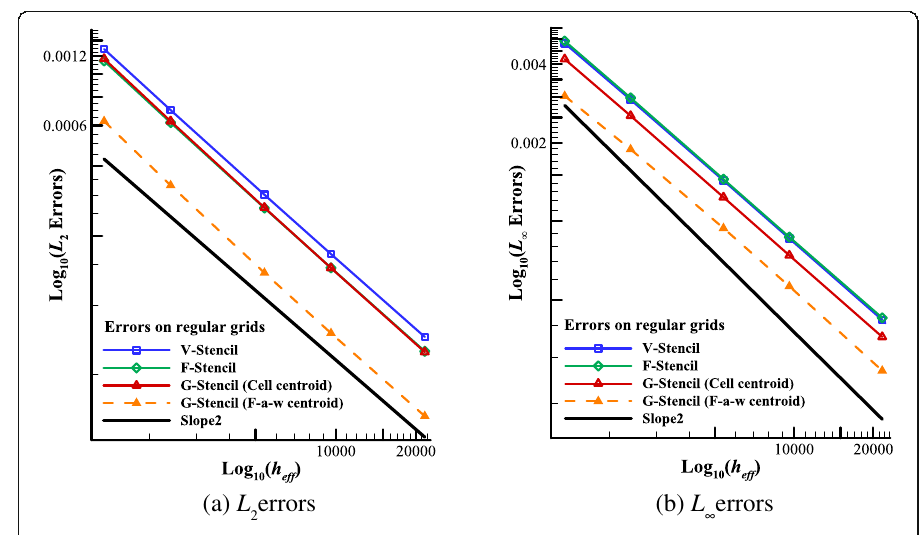
Fig. 13 ( a ) L 2 and ( b ) L ∞ errors. Errors of different stencils on regular grids with AR = 10 3